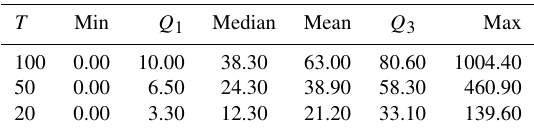
Table 1. Relative absolute deviation (rad T ) between the annual and mixed probability estimator (%). Q 1 and Q 3 are the lower and up- per quartiles.